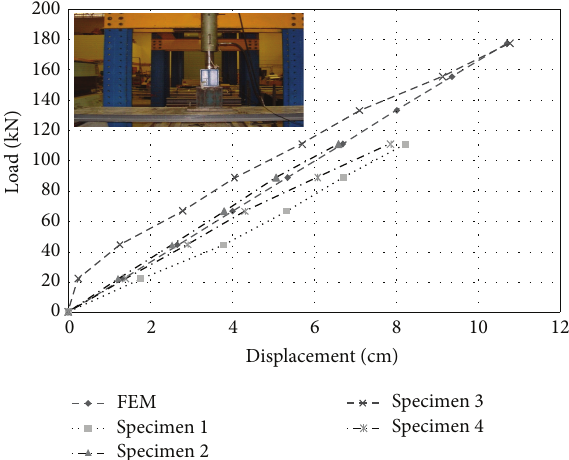
Figure 13: Load-deflection response of a single ProDeck4 module.